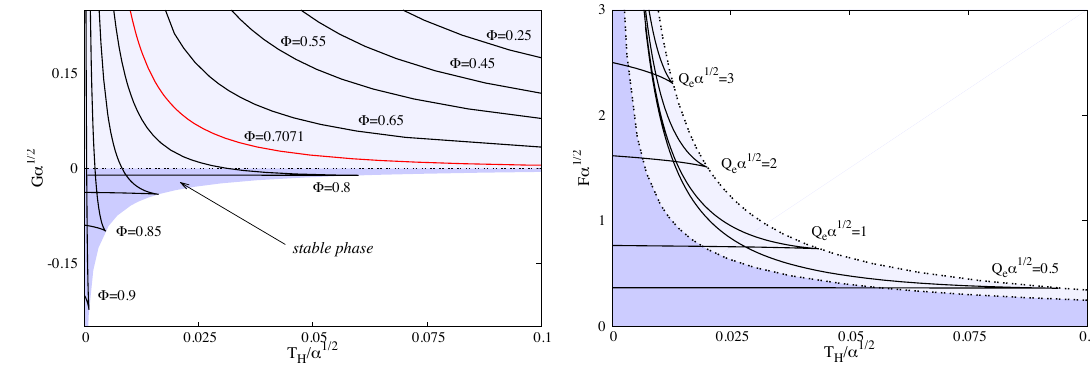
Figure 9 . (Left panel) The Gibbs free energy vs. temperature for (cid:12)xed chemical potential ensemble. (Right panel) The Helmholtz free energy vs. temperature for the (cid:12)xed charge ensemble. In both plots, the BHs exist in the light blue region only, the shaded blue region corresponding to stable phase